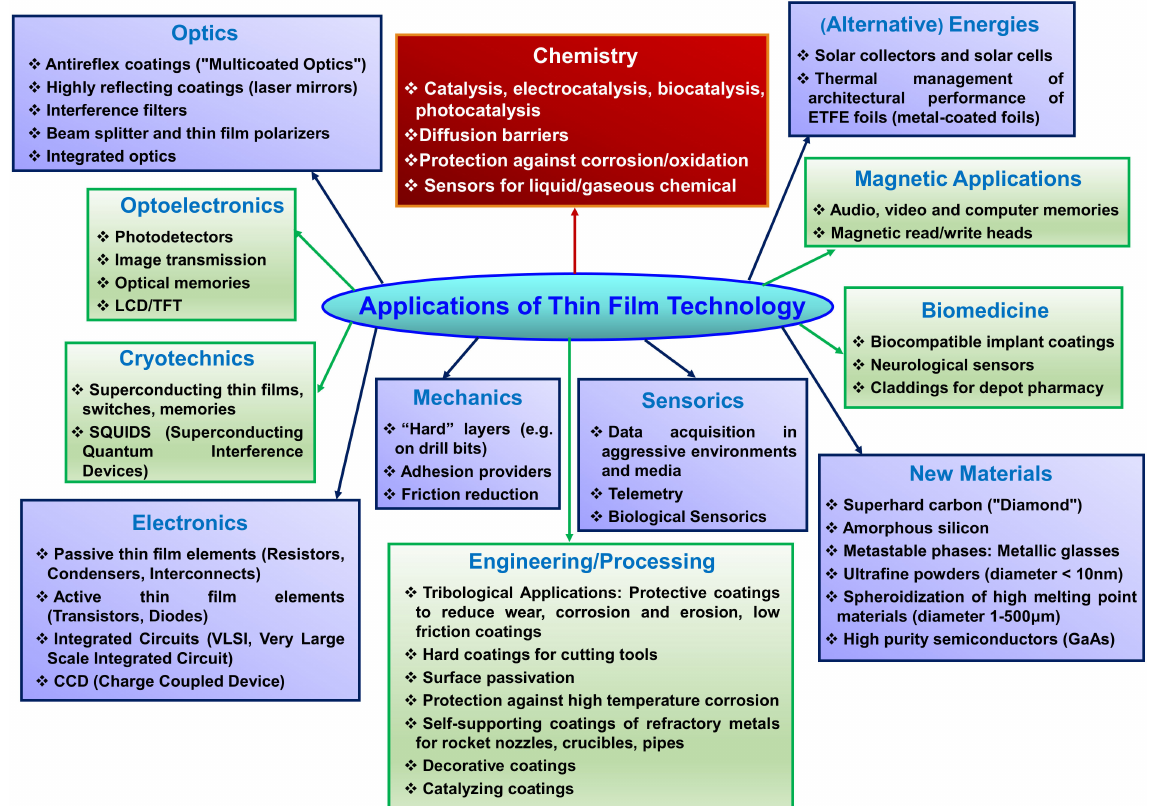
Figure 1. Applications of thin film technology (adapted from Ref.